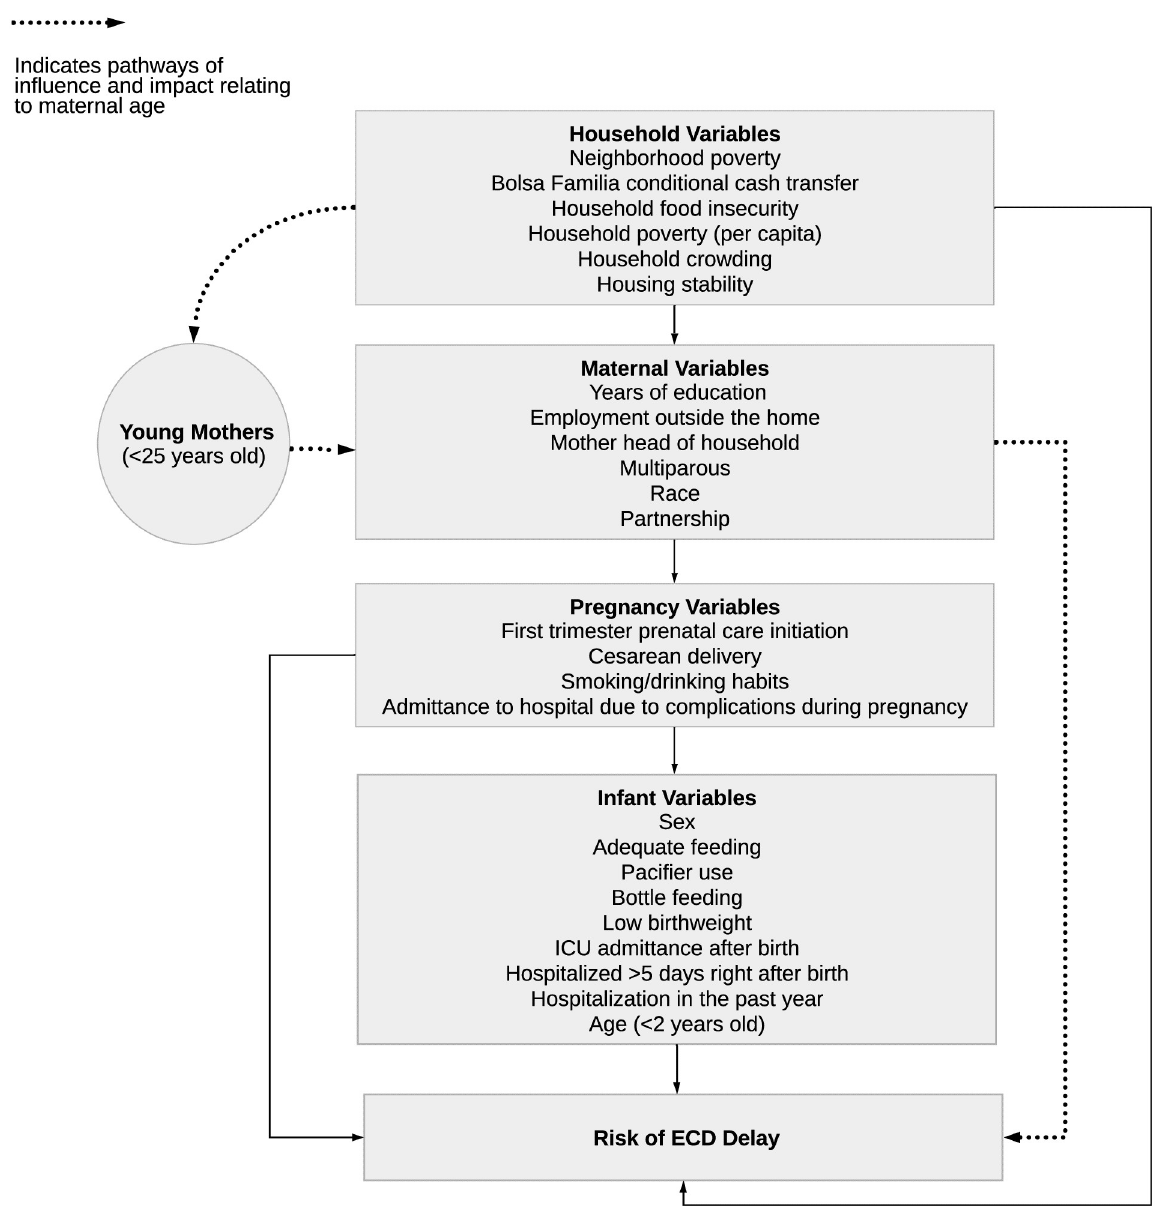
Fig 2. Conceptual model of variables associated with maternal age and ECD